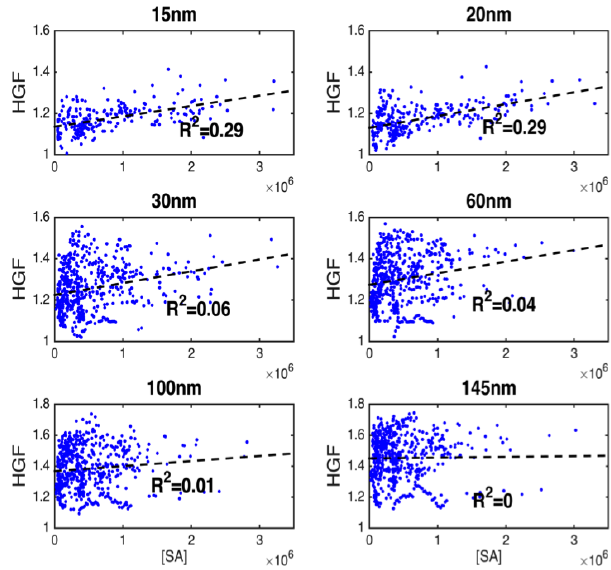
Figure 8. HGF of 15, 20, 30, 60, 100 and 145nm particles with sulfuric acid concentration in gas phase during the time of NPF. The dashed lines indicate the linear fit to the full